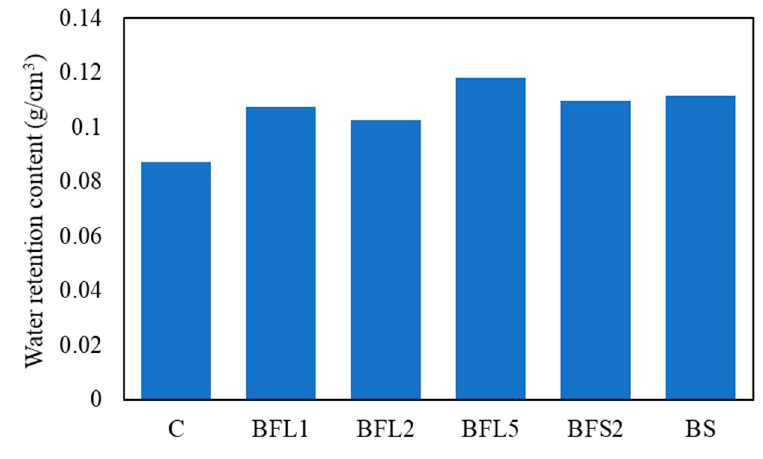
Figure 7. Water retention content.